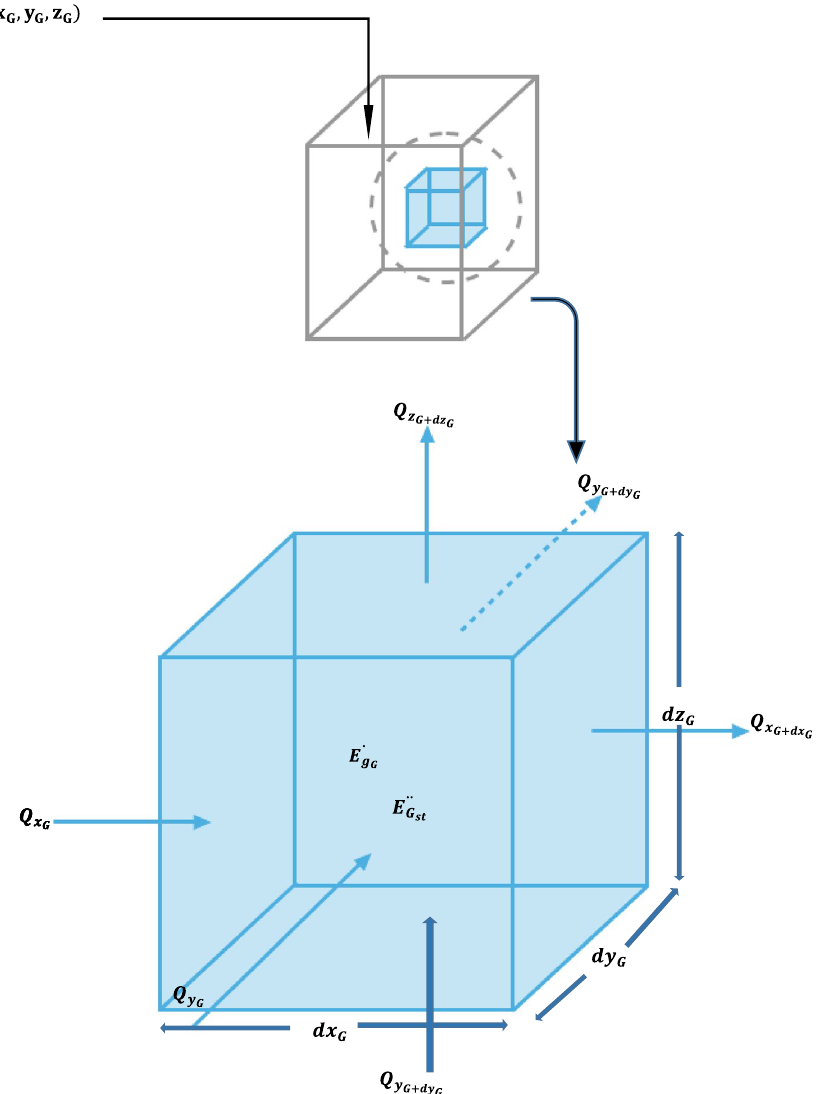
Figure 1. Conduction analysis in Cartesian